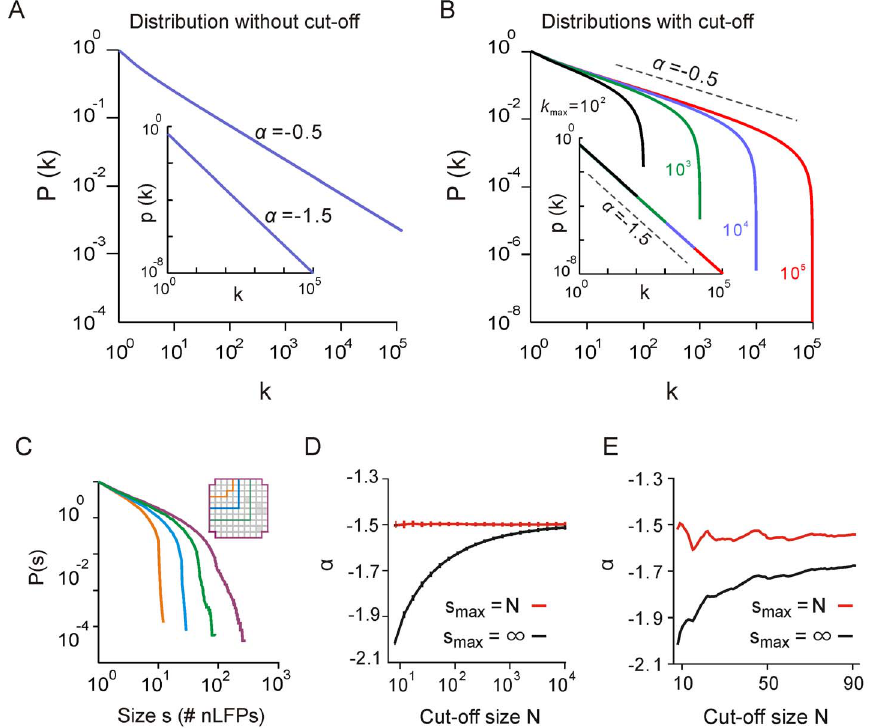
Figure 7. The impact of a cut-off on visualizing a power-law distribution and estimating the exponent. (A) Probability mass function (PMF, inset; calculated as p ( k ) ~ k { 1 : 5 = f (1 : 5) , where f ( x ) is the Riemann zeta function) and the corresponding complementary cumulative distribution X ? p ( k ) ] for a power-law distribution without cut-off, i.e., the power law holds for arbitrarily large k . The exponents are 2 [CCDF, defined as P ( k ) ~ k X k max l { 1 : 5 if k # k max and p ( k ) ~ 0 if k . k max , where k max is the 1.5 and 2 0.5 for the PMF and CCDF, respectively. (B) PMFs (inset; defined as p ( k ) ~ k { 1 : 5 = l ~ 1 X k max p ( k ) ] for power-law distributions with cut-off sizes, k max =10 2 , 10 3 , 10 4 , and 10 5 cut-off size) and corresponding CCDFs [defined as P ( k ) ~ k [dashed lines: power law with exponent a = 2 1.5 (inset) and 2 0.5 shown for comparison]. (C) CCDFs for cluster sizes in monkey 1 (see Fig. 1E for corresponding PMFs). (D) Power-law exponents were estimated for synthetic data with varying cut-off size, N , ranging from 8 to 10 4 , assuming the correct model with upper bound ( s max = N , red) or an incorrect model without cut-off ( s max = ‘ , black). Exponents were estimated using a maximum- likelihood approach (shown are the means with error bars indicating the standard deviation across n =10 synthetic distributions). (E) Power-law exponents were estimated for size distribution of monkey 1 with varying cut-off size, N , ranging from 10 to 91, assuming the correct model with upper bound ( s max = N , red) or an incorrect model without cut-off ( s max = ‘ , black).